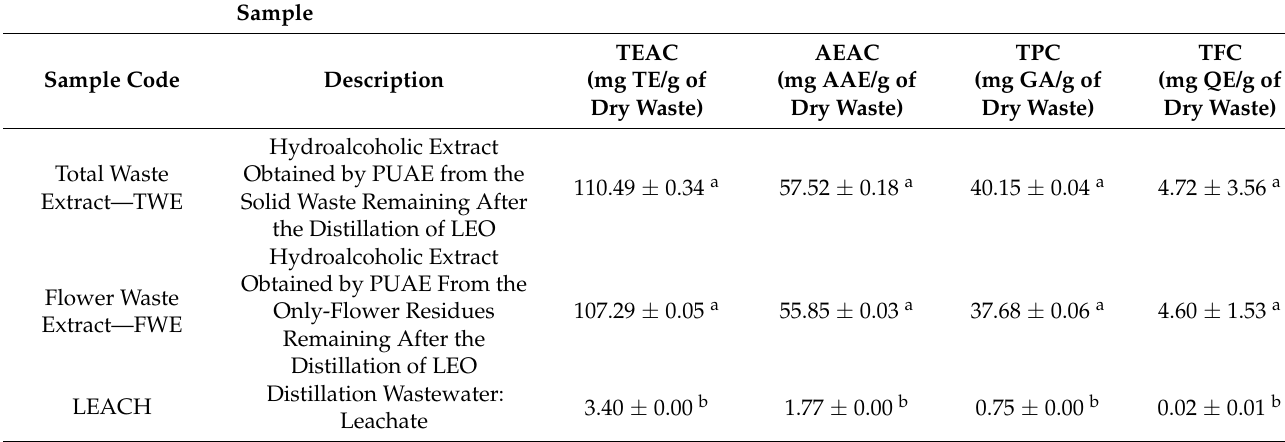
Table 2. Radical scavenging activity (RSA), total polyphenol content (TPC) and total flavonoid content (TFC) of the solid waste extracts obtained by PUAE: the total waste extract (TWE) and the only-flower waste extract (FWE). The chemical characterization of the corresponding distillation wastewaters (Leachate: LEACH) was reported